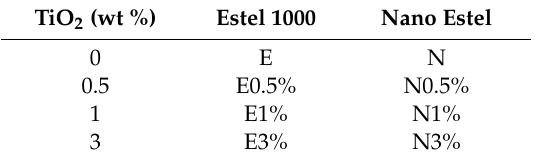
Table 1. Conditions used in the experiment. Acronyms are also